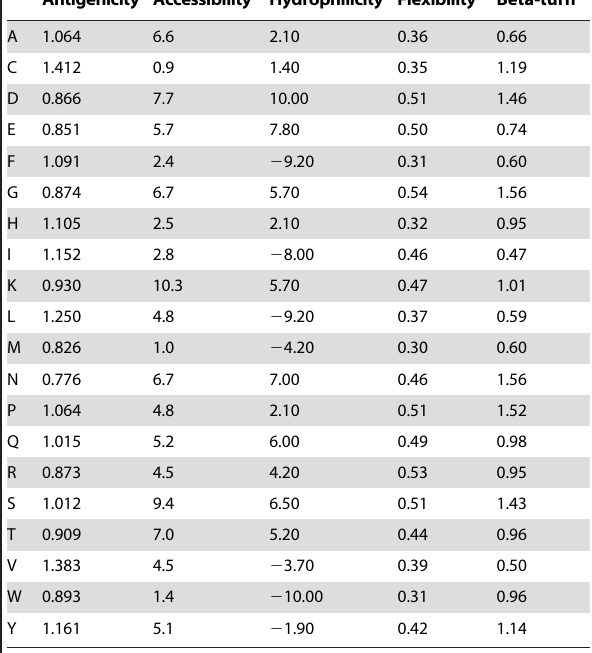
Table 1. Five amino acid scales used for the features